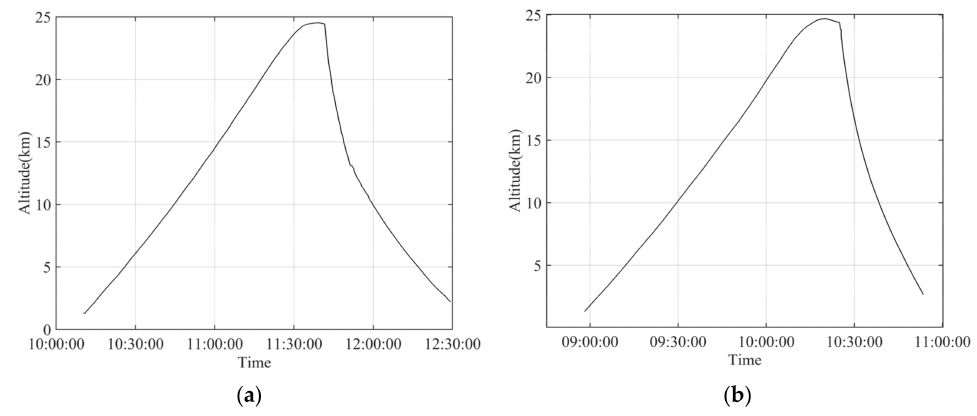
Figure 6. The altitude monitored by GPS on ( a ) Day 1 and ( b ) Day 2, respectively.